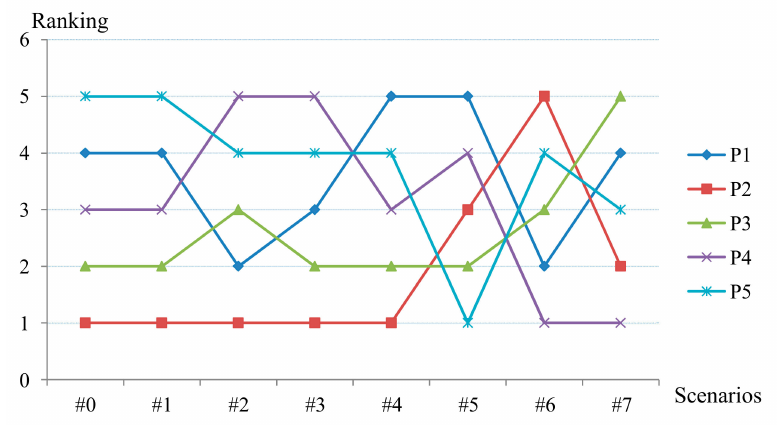
Figure 4. The changing of alternative ranking in different scenarios.